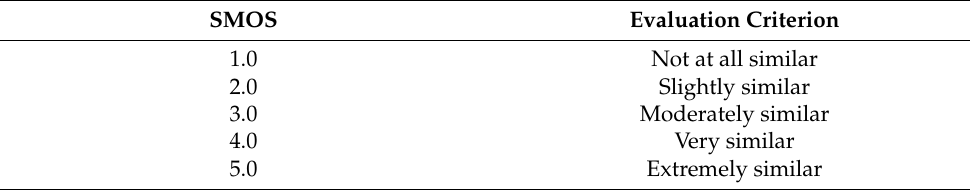
Table 2. SMOS scoring criteria.